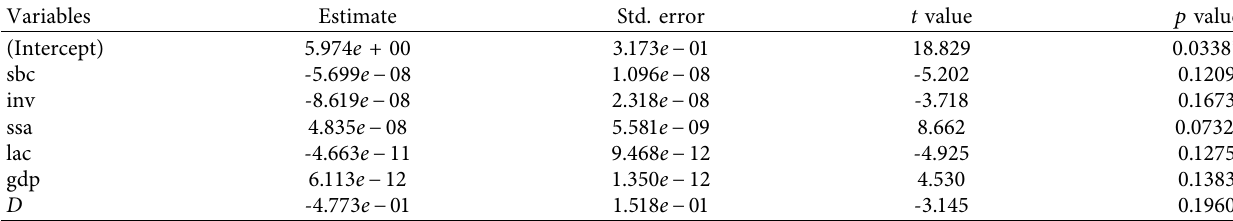
Table 7: Results of regression analysis after taking